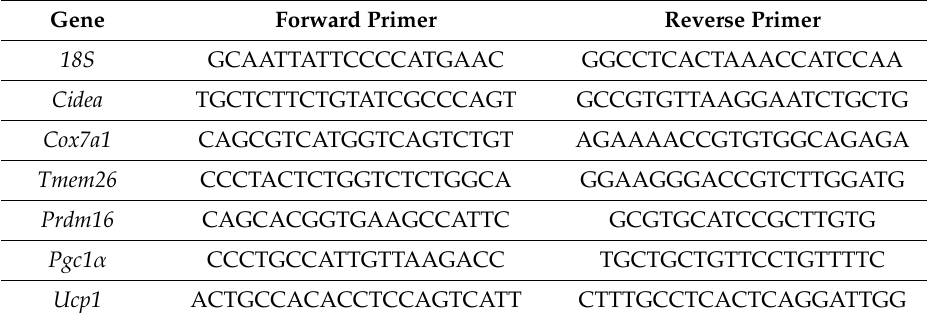
Table 1. Primer sequences used for qPCR